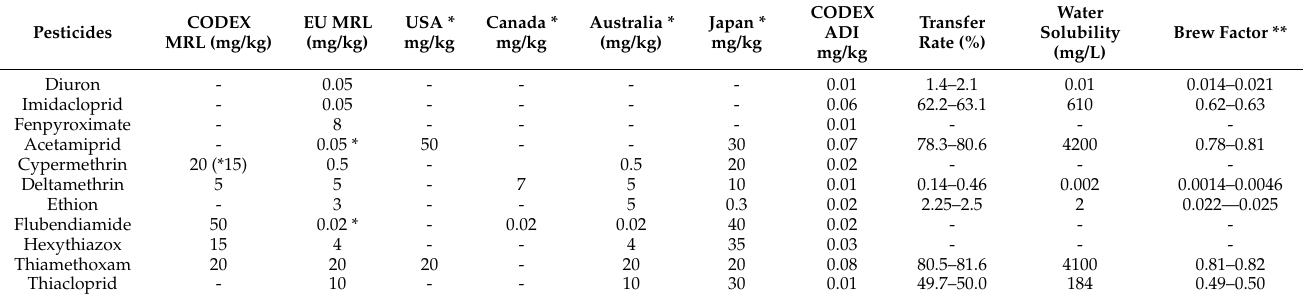
Table 3. Those exceeding the ADI value are shown in bolt black. ** countries from where tea came to Turkey. —In this country, the Brew Factor for this pesticide has not been reported. Table 3. MRL values of pesticides used in tea according to countries and ADI values according to Codex Alimentarius. Additionally, Transfer rate of pesticide residue from tea brew and Brew Factor.